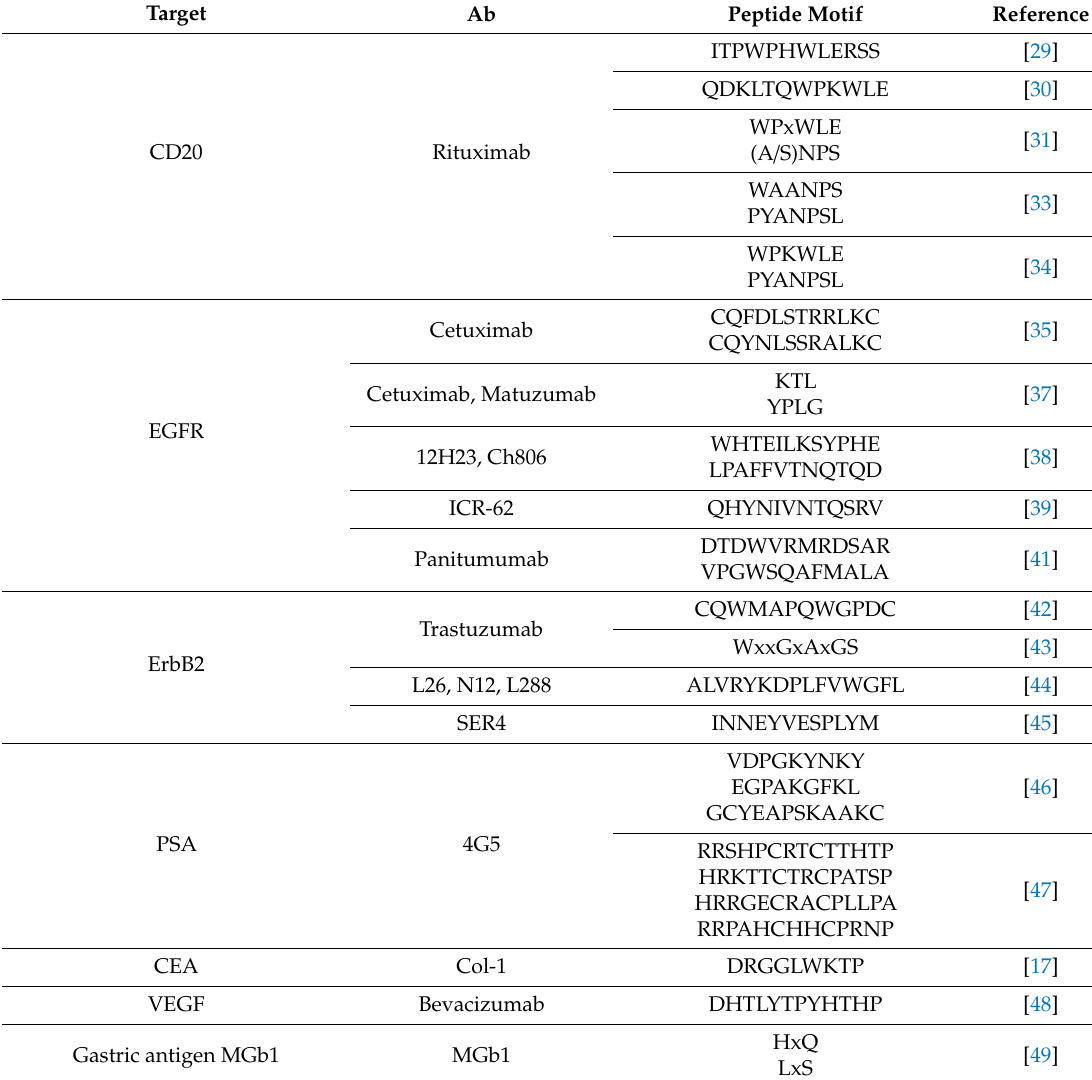
Table 1. Mimotopes of tumor-associated